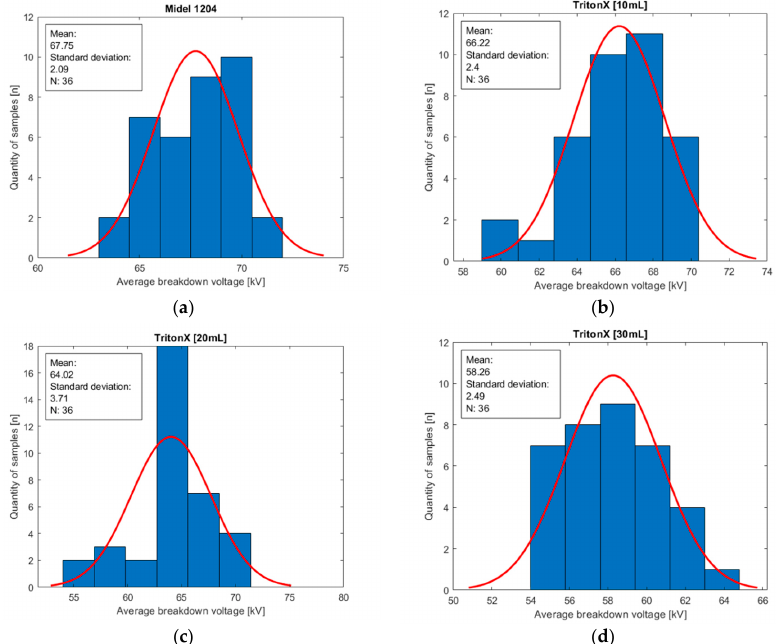
Figure 9. Histograms of oil population Midel 1204 with different concentrations of surfactant Triton X: ( a ) base sample of Midel 1204 ; ( b ) 10 mL of surfactant Triton X in a sample; ( c ) 20 mL of surfactant Triton X in a sample; ( d ) 30 mL of surfactant Triton X in a sample.